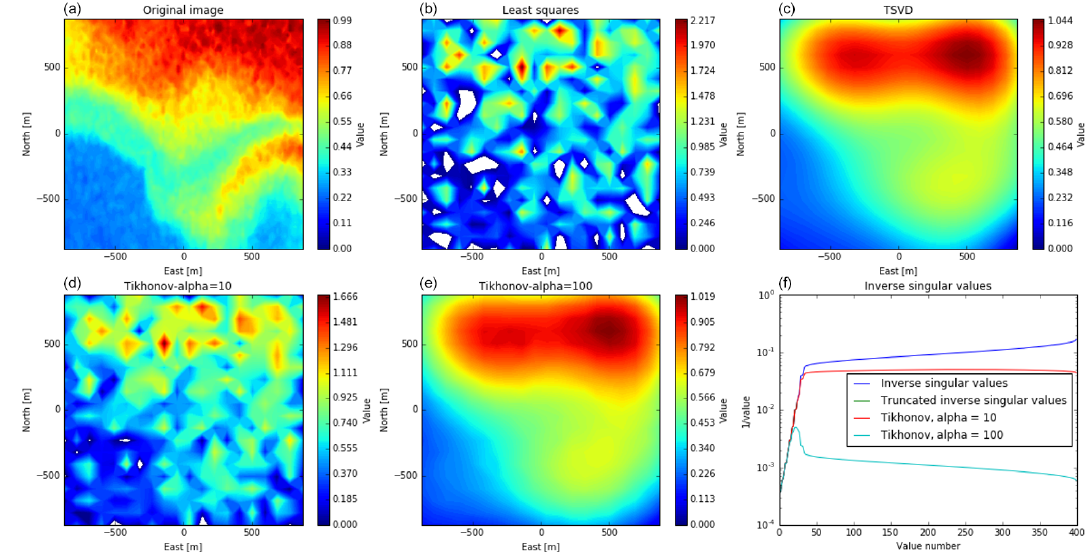
Figure 11. Comparison of reconstructions, using SVD for the MIMO case only, using the core antennas. The plots correspond to Fig. 9.